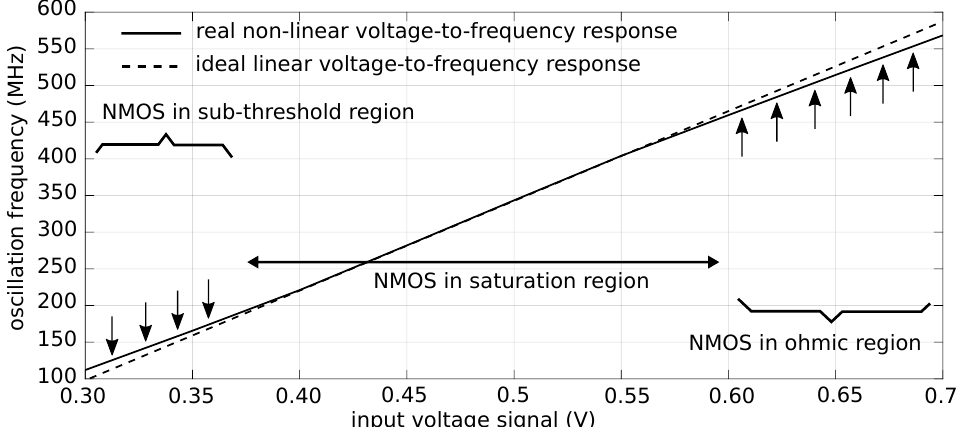
Figure 4. Voltage-to-frequency conversion function of a conventional ring-oscillator (solid line) and an ideal linear curve estimation (dashed